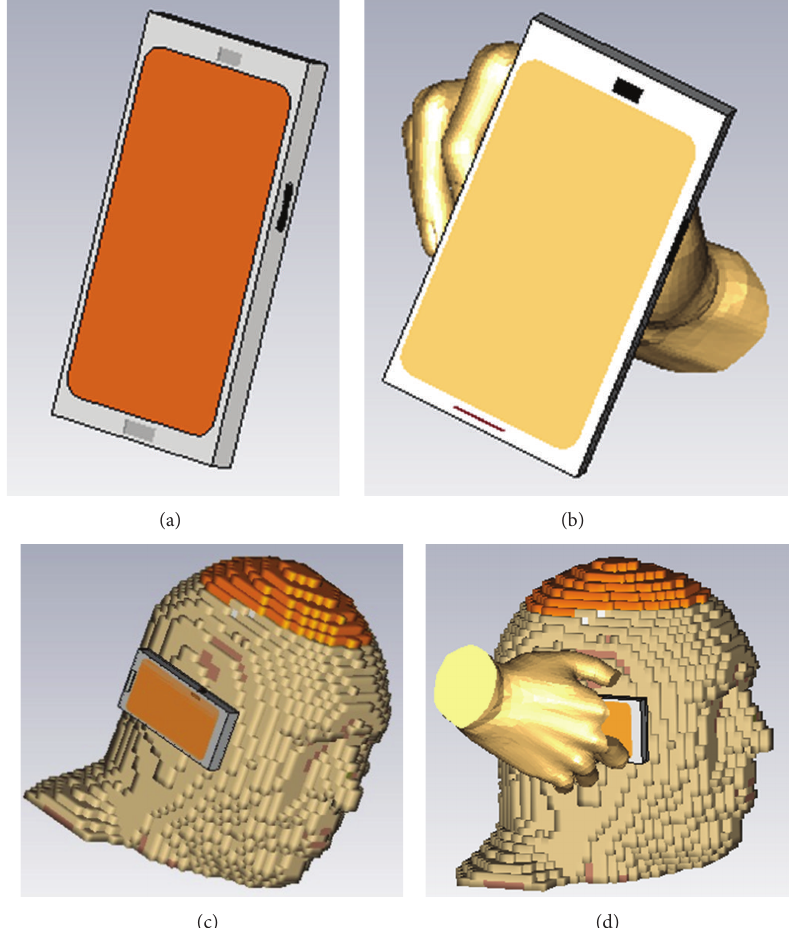
Figure 8: CTIA-defined four different test positions: (a) free space, (b) browsing mode, (c) talking position, and (d) talking position with